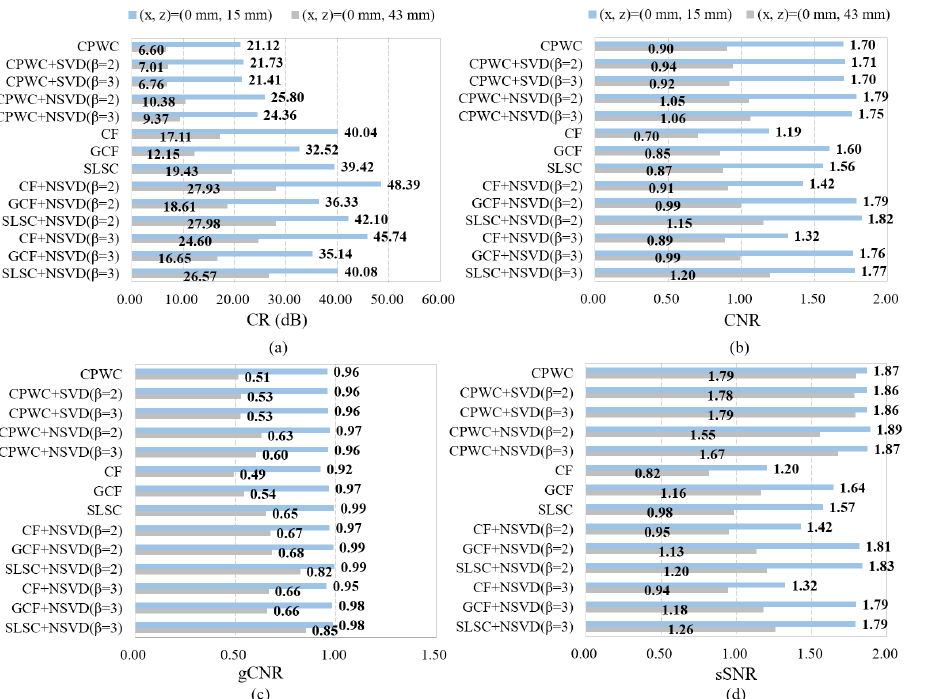
Figure 13. ( a ) CR, ( b ) CNR, ( c ) gCNR, and ( d ) sSNR for each beamforming method in images of experimental phantom with cyst targets. The first and second column contain the results of anechoic cysts centered at ( x , z ) = ( 0 mm, 15 mm) and ( x , z ) = ( 0 mm, 43 mm),